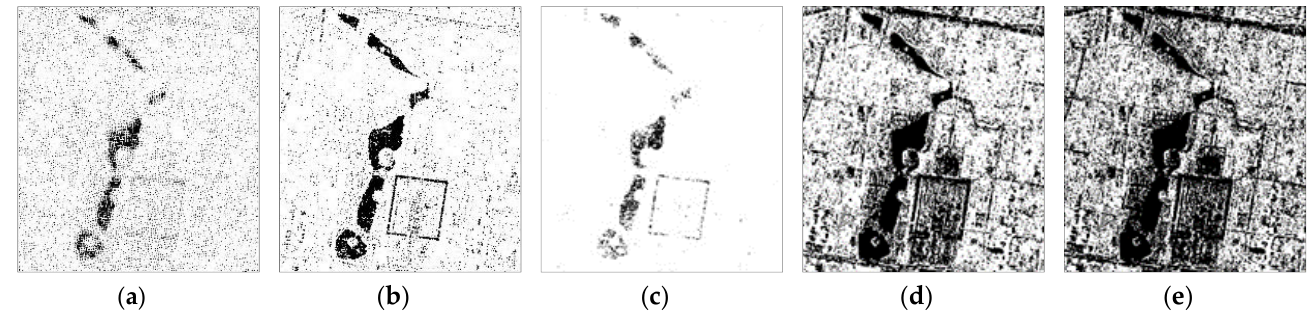
Figure 4. The optimal feature maps of Data A. ( a ) – ( e ) are maps of a scale 1 – 5, respectively.